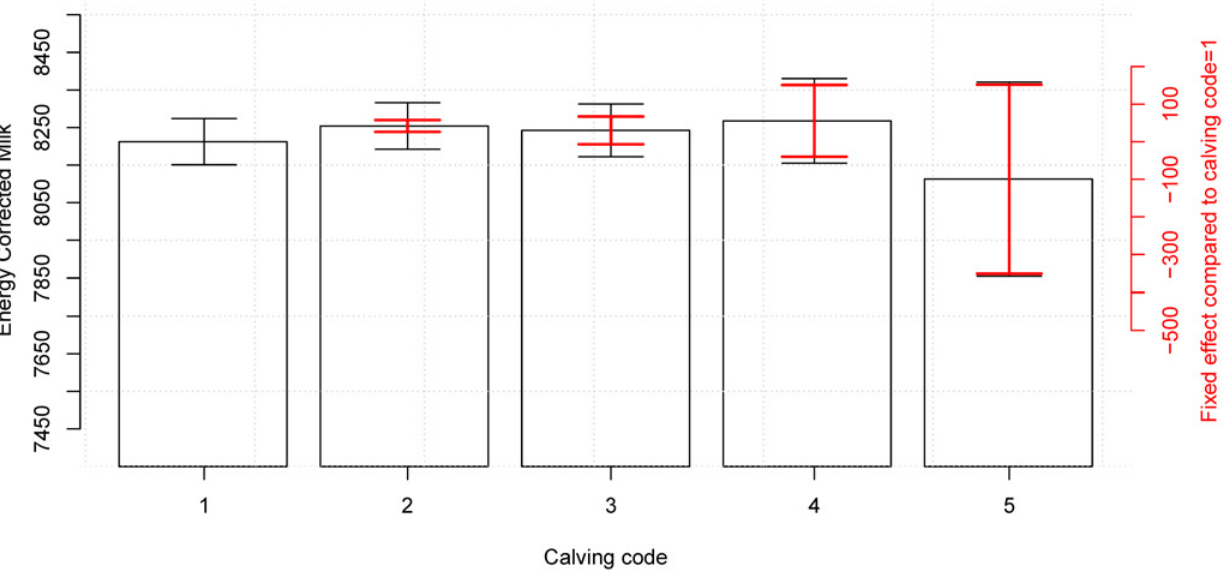
Fig 4. Effect of calving difficulty on milk production in the first lactation period. When using the best model (Eq 2) including yearly, seasonal, calving, and herd effects there is a significant difference of 41.80 ECM ( sd = 8.015) between having an easy calving (calving code = 1) and having a easy calving with help (calving code = 2) (red CI). When including the variance of the reference level the difference is masked (black CI). The numerical results are available in Table 4.